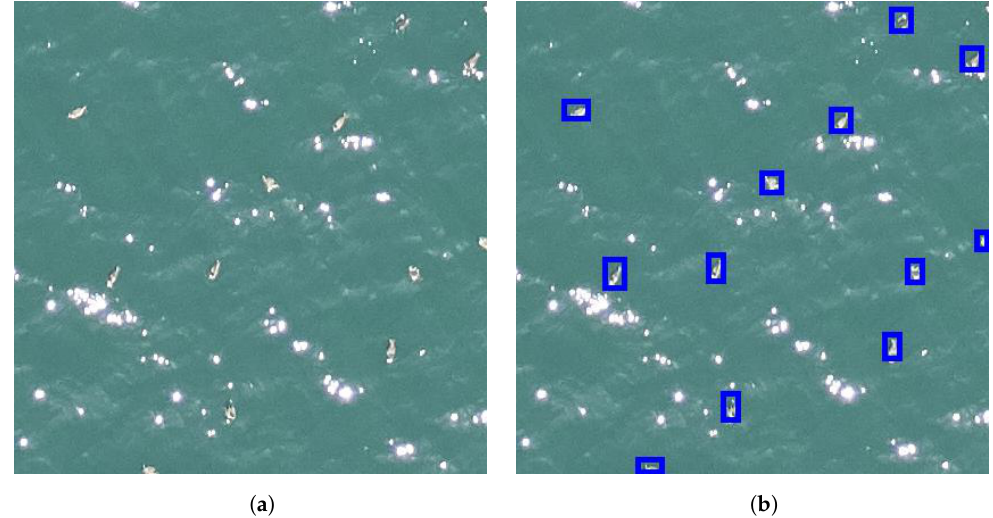
Figure 4. Original aerial image of marine birds ( a ) and its ground-truth bounding boxes ( b